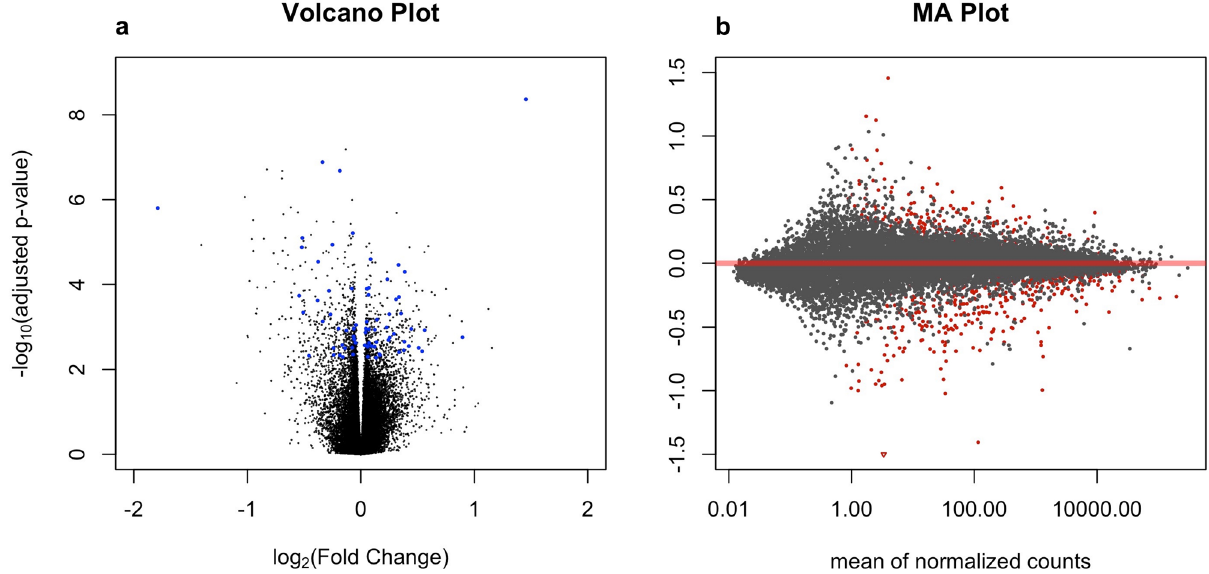
Figure 2. Initial quality checking of the RNA-seq data based on the training set. ( a ) Volcano plot of − log 10 adjusted p values (on the y-axis) versus log 2 fold changes (on the x-axis) using the training set. The blue points correspond to the 73 RSRS genes. ( b ) MA plot, which is a scatter plot of log2 fold changes (on the y-axis) versus the mean of normalized counts (on the x-axis), where points were colored red if the genes were selected. Points which fall out of the window were plotted as open triangles pointing either up or